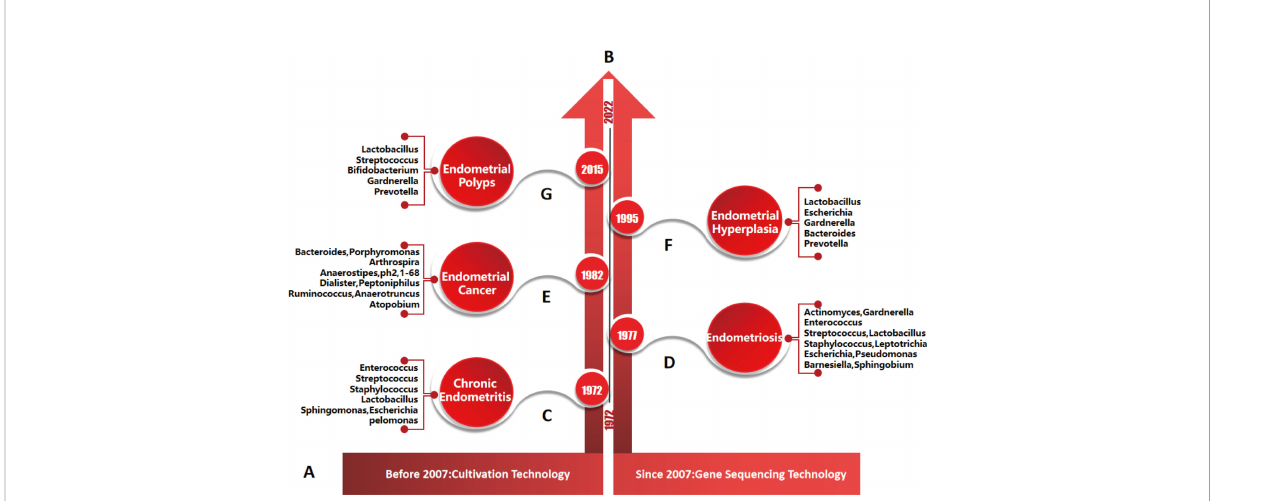
FIGURE 5 Timeline of endometrial diseases, major microorganisms and their detection methods. (A) , detection methods of endometrial microorganisms. According to the literature, culture technology was mainly used before 2007, and gene sequencing technology was mainly used after 2007. (B) , research progress of endometrial diseases and microorganisms: studies on the relationships between, chronic endometritis, endometriosis, endometrial cancer, endometrial hyperplasia, endometrial polyps and microorganisms were fi rst reported in 1972, 1977, 1982, 1995 and 2015, respectively. (C – G) , main species of endometrial microbiota were detected by genus sequencing technology in different endometrial